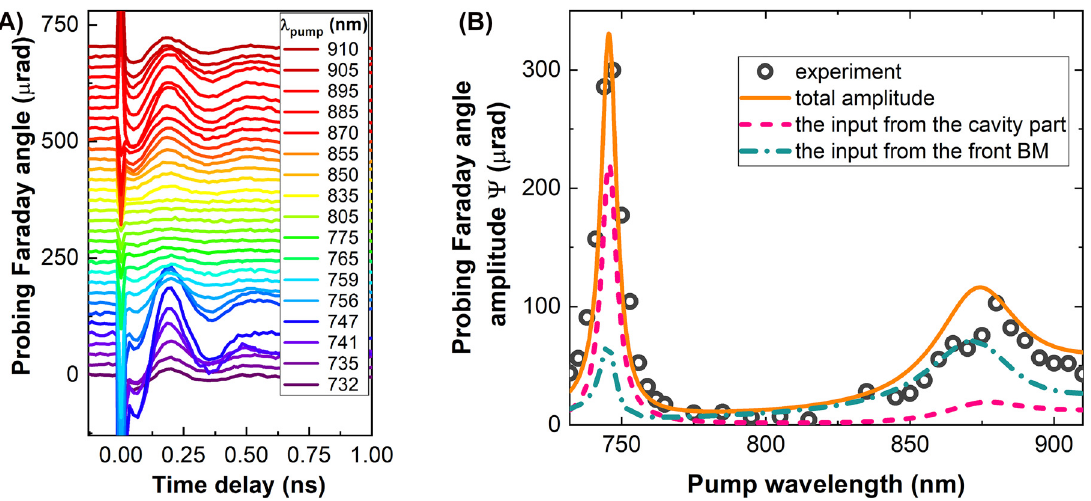
Figure 2: Probing Faraday angle. (A) Experimentally measured time-resolved change of the Faraday rotation of the probe pulses at different pump wavelengths from 732 to 910 nm. All curves have offsets for clarity of representation. (B) Experimentally measured (circles) and calculated (orange solid line) amplitudes of the oscillations seen in probe Faraday rotation as a function of the pump wavelength. The pink dashed curve represents the contribution of the nanocavity of the MPC and the blue dash-dotted curve provides the input from the front